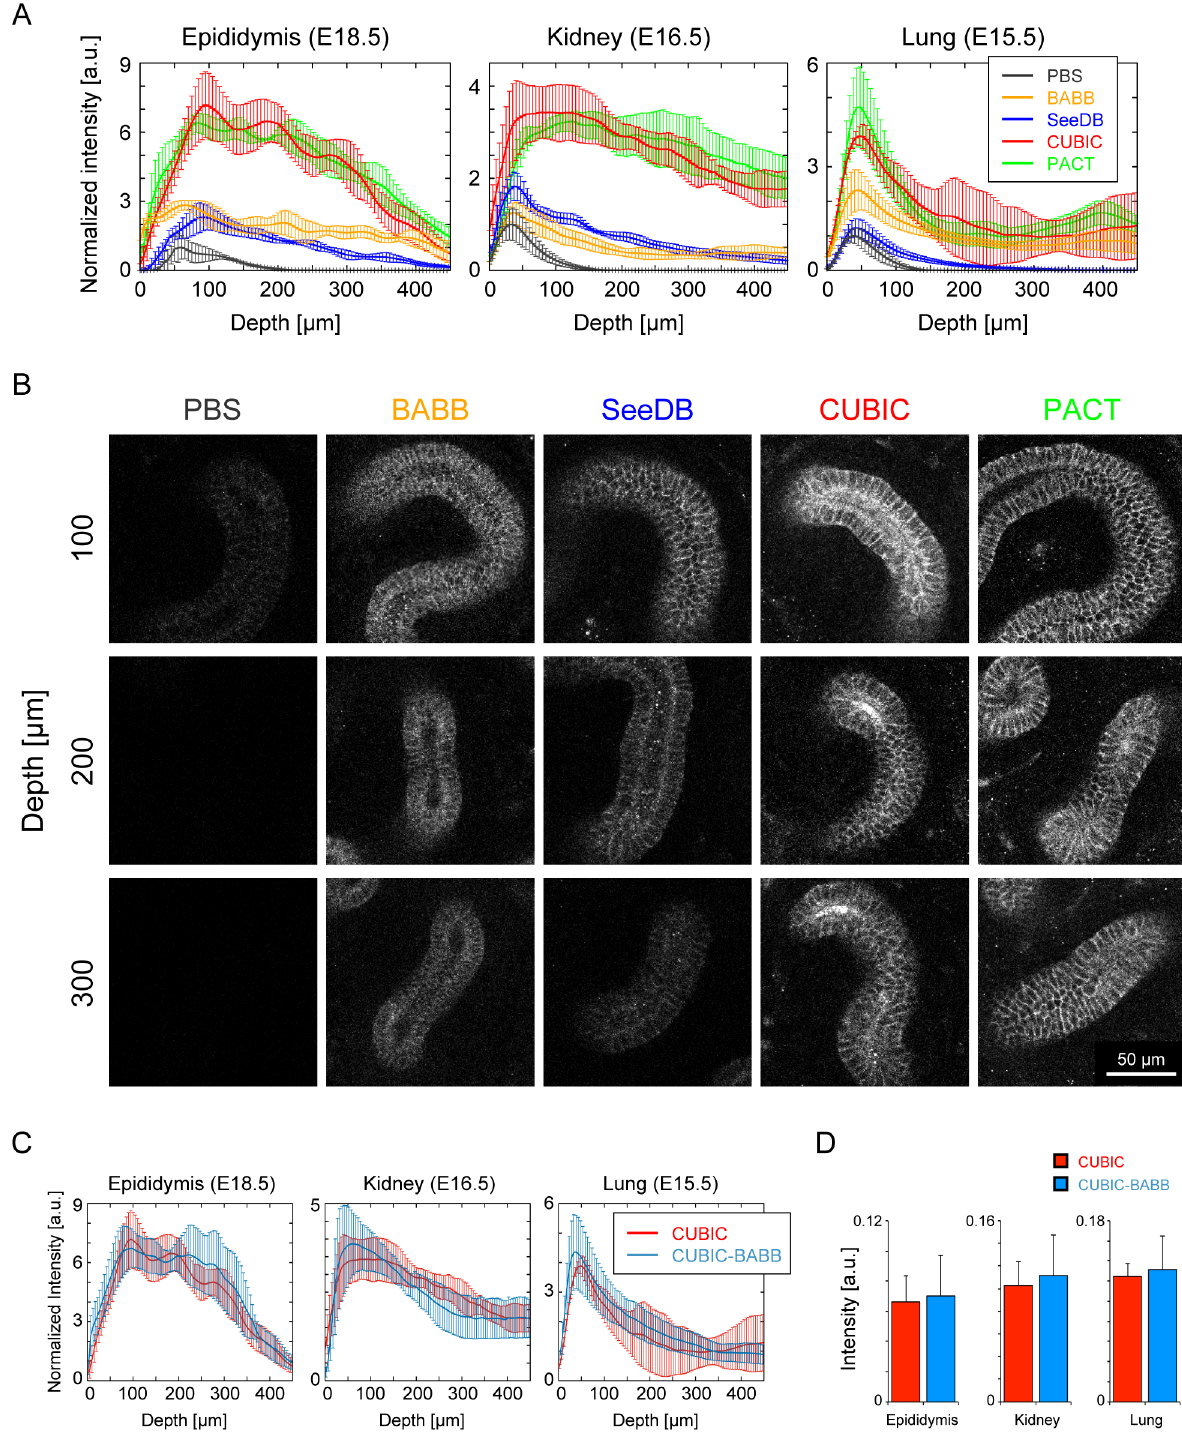
Fig 3. Comparison of immunofluorescence for E-cadherin among optical clearing methods. Different optical clearing methods, including BABB, SeeDB, CUBIC, and PACT, were applied to the embryonic epididymis (E18.5), kidney (E16.5), and lung (E15.5), each of which was immunolabeled with E- cadherin. PBS was used as a control solution. The color represents the optical clearing method. (A) Plot of the mean E-cadherin immunofluorescence intensity against the depth from the bottom of tissues embedded onto the dish. The mean intensity was normalized to the maximum intensity of PBS-treated samples (black) in each organ. n = 8. The error bars represent the standard deviation (s.d.). (B) Representative images of E-cadherin immunofluorescence in the epididymis are shown for each depth from the bottom of the tissue (row) and for each optical clearing method (column). Scale bar: 50 μ m. (C) Plot of the